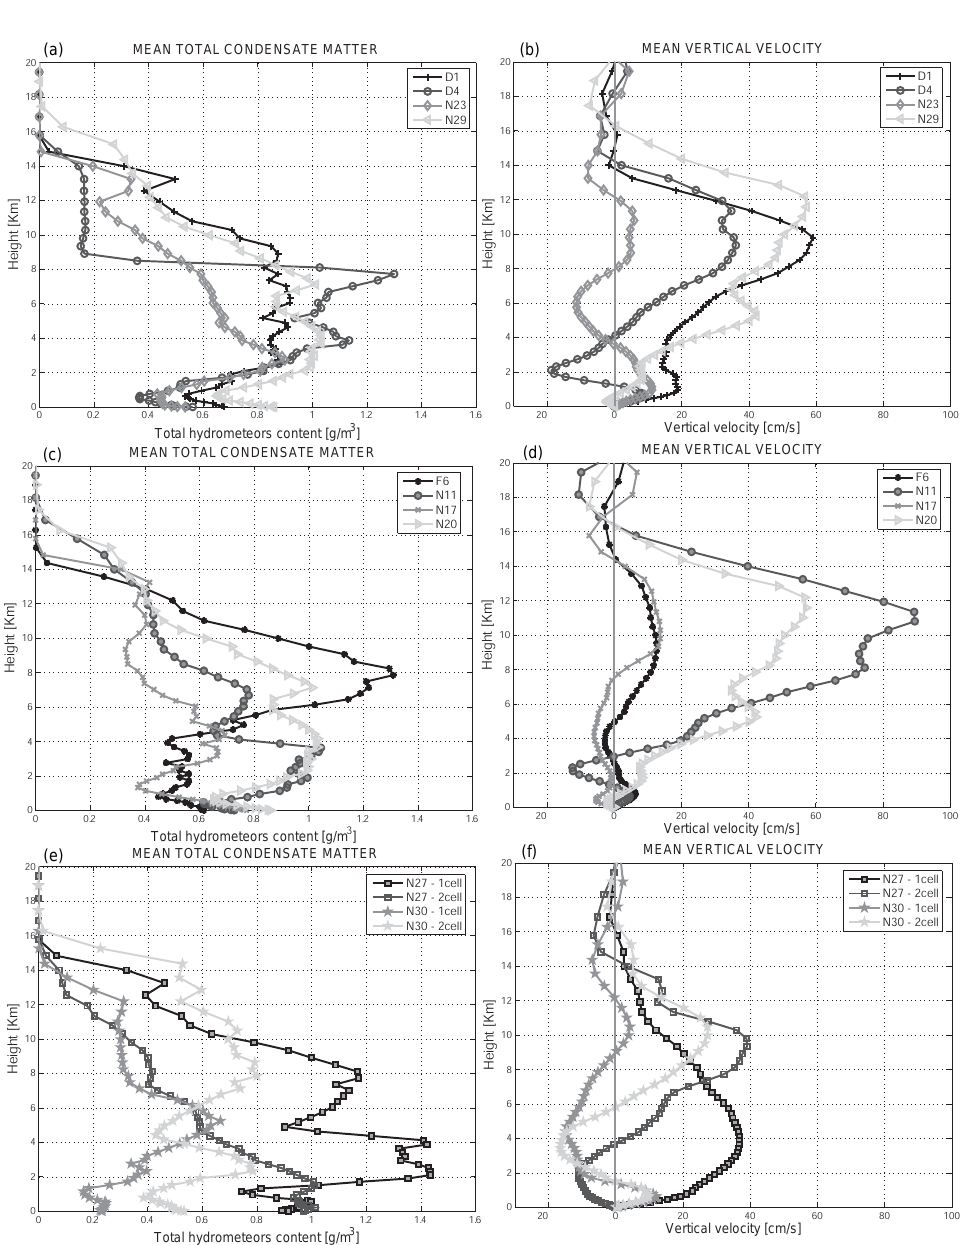
Figure 7. MM5 mean vertical profiles of cloud total condensate (sum of all hydrometeors) and vertical velocity at the maximum stage. Profiles are averaged for each layer within the volume encapsulating